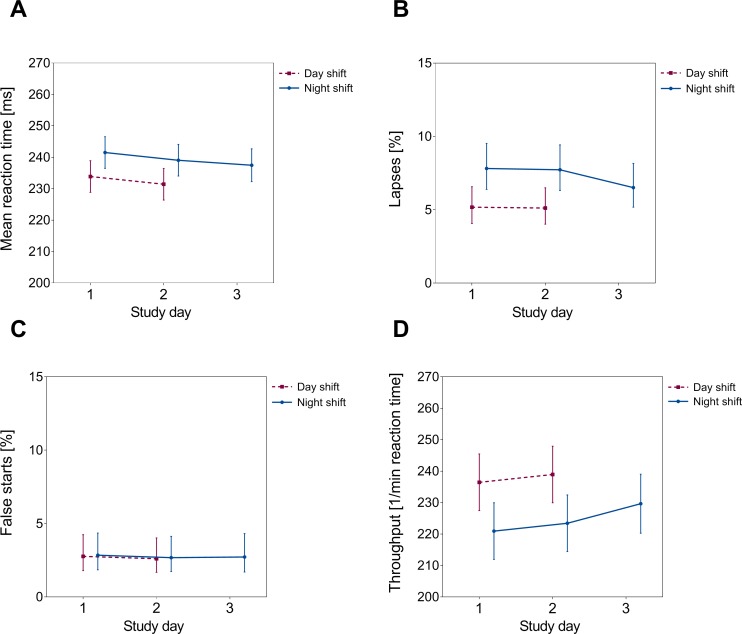
Mean reaction time (panel A) and errors (panels B-D) according to study day: LS-means and associated 95% confidence intervals, adjusted for age, chronotype, OSA and season. Please note that the scale of the y-axis does not start at “0” in panels A and D.